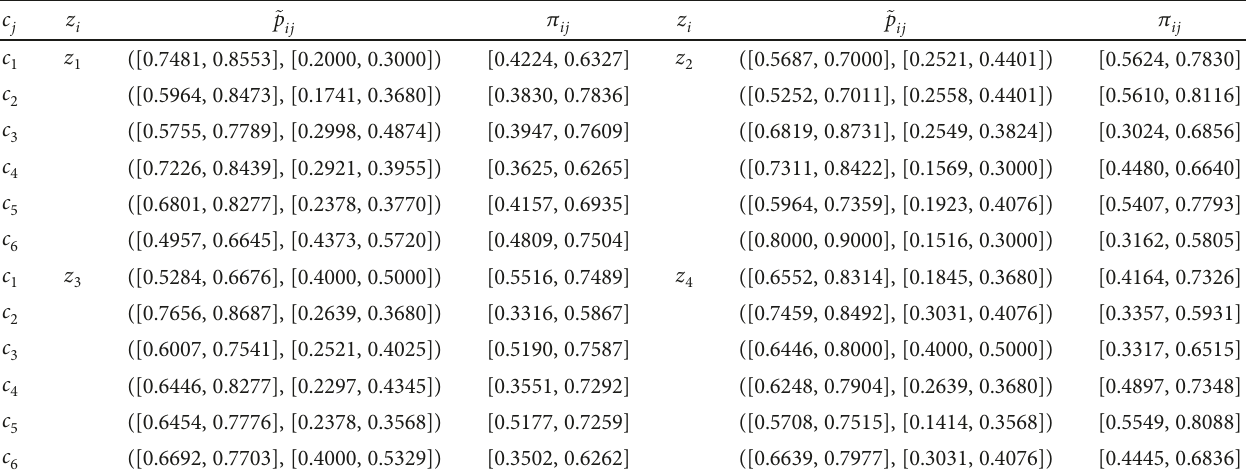
Table 6: IVPF evaluative ratings in the risk evaluation problem of technological innovation.